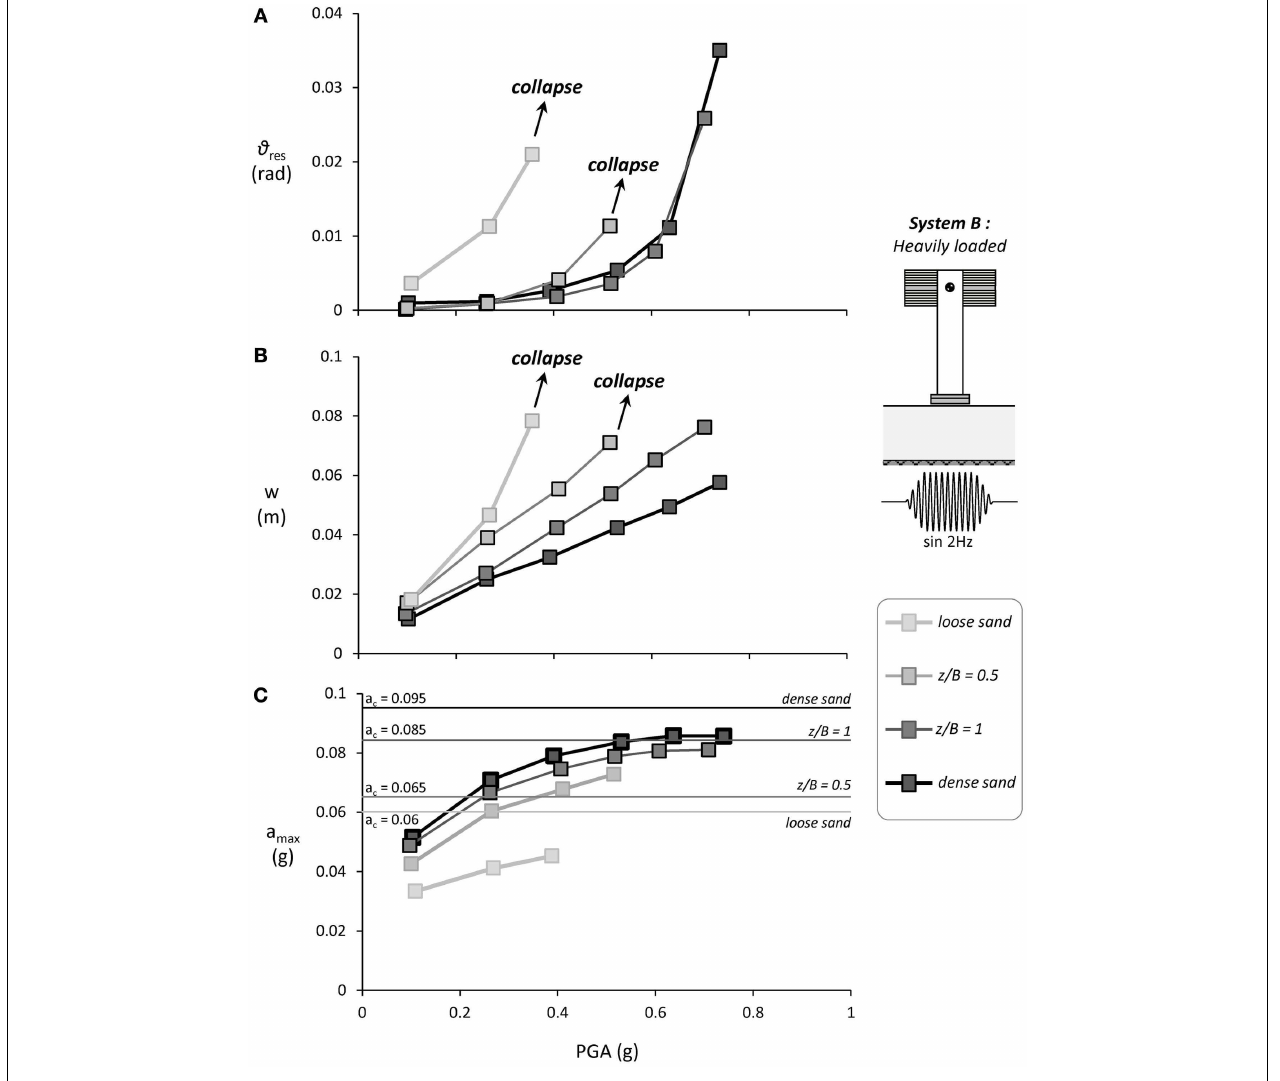
FIGURE 13 | Synopsis of the performance of the heavily loaded System B subjected to seismic shaking sequence III: (A) residual rotation ϑ res ; (B) settlement w as a function of the excitation PGA (measured at the